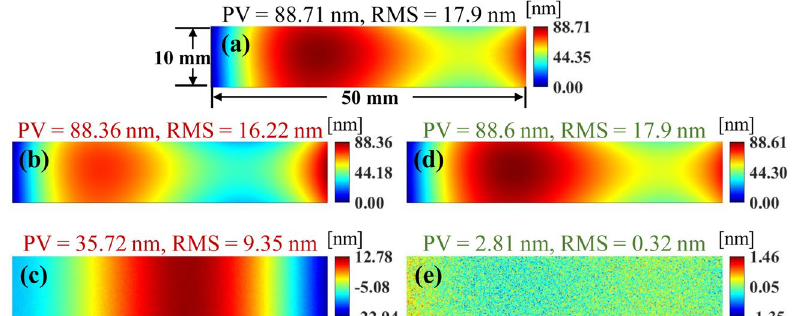
Figure 3. Calculation results in CA using γ ini and γ opt : ( a ) desired height removal map; ( b ) removed height using γ ini ; ( d ) residual using γ ini ; ( c ) removed height using γ opt ; and ( e ) residual using γ opt .